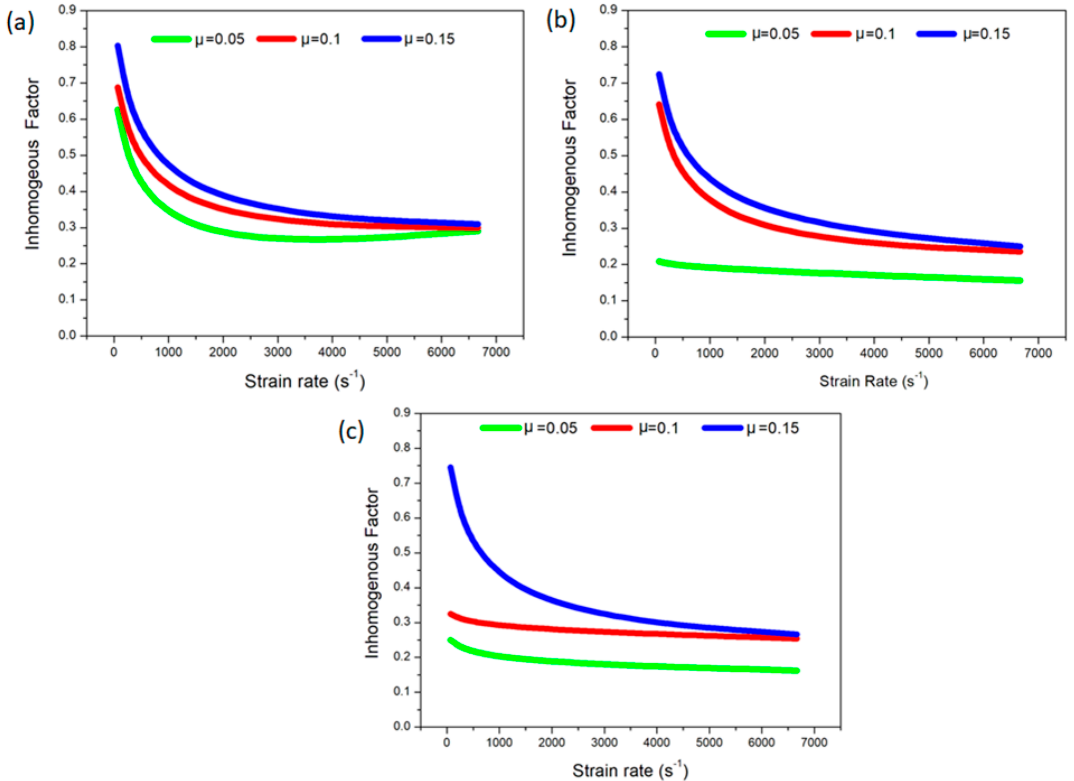
Figure 6. Inhomogeneous factor at ( a ) 25 °C; ( b ) 250 °C; ( c ) 500 °C.